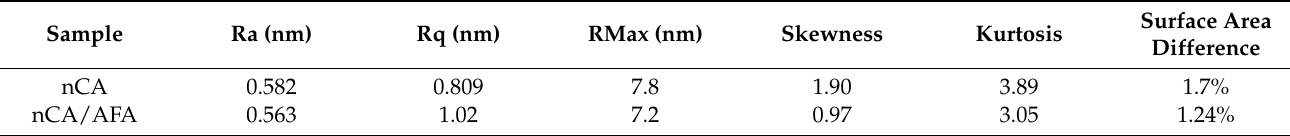
Figure 6. Three-dimensional reconstructions of ( a ) nCA and ( b ) nCA/AFA based on 1 × 1 µm atomic force microscopy (AFM) scans. Table 1. AFM roughness analysis of nCA and nCA/AFA.